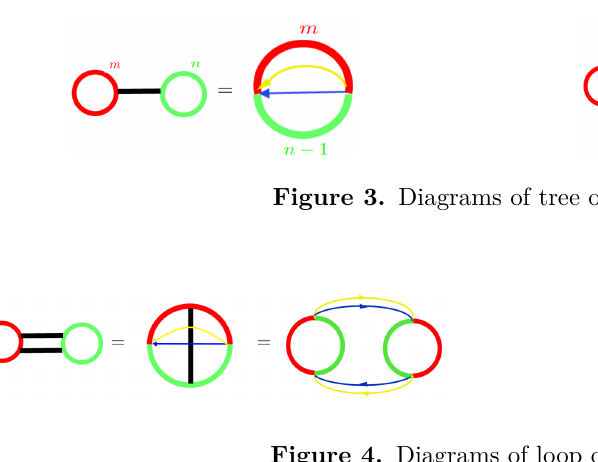
Figure 4. Diagrams of loop